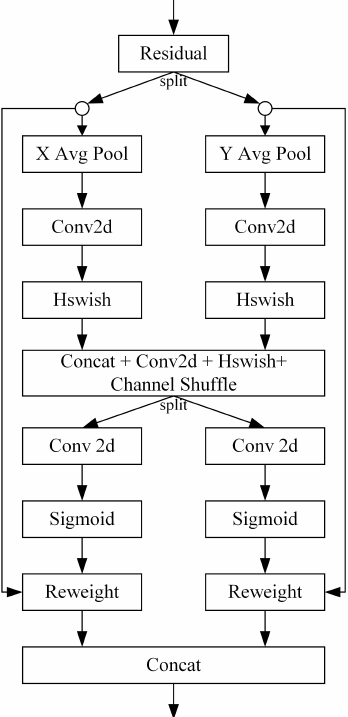
Figure 5. The structure of the CSAT